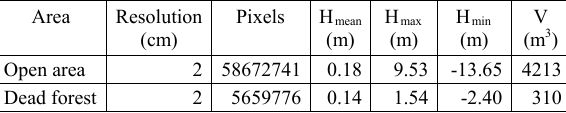
Table 4. Comparison of manual tube (H T ) and UAV (H UAV ) snow depth measurements in dead forest area.